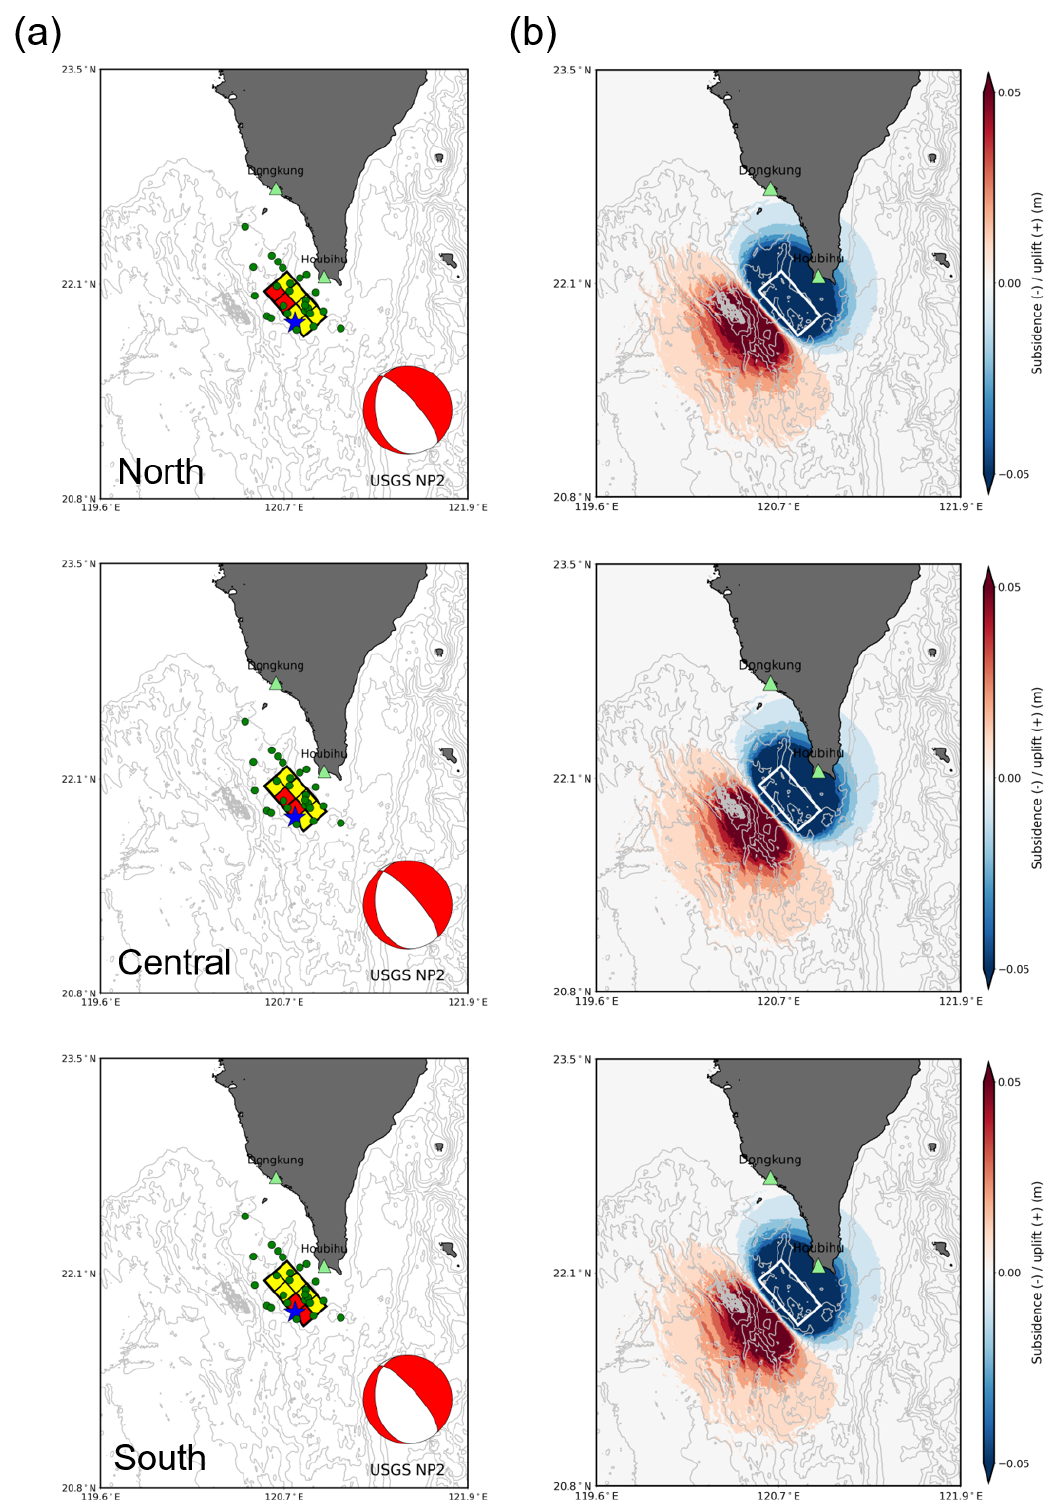
Figure 5. (a) Map of subfault boundaries with different asperity locations for the first earthquake ( M w 7.0). (b) Coseismic crustal vertical displacement calculated using the fault parameters of the subfaults. The beach ball denotes the focal mechanisms of USGS’s NP2 nodal planes for the first earthquake. The subfaults in red represent large slip areas, and the subfaults in yellow represent background slip areas. The large slip area was located only at the shallow part of the entire fault area. The blue stars represent the epicenter of the first earthquake, and the green circles represent the aftershocks. The tide gauge stations are plotted as green